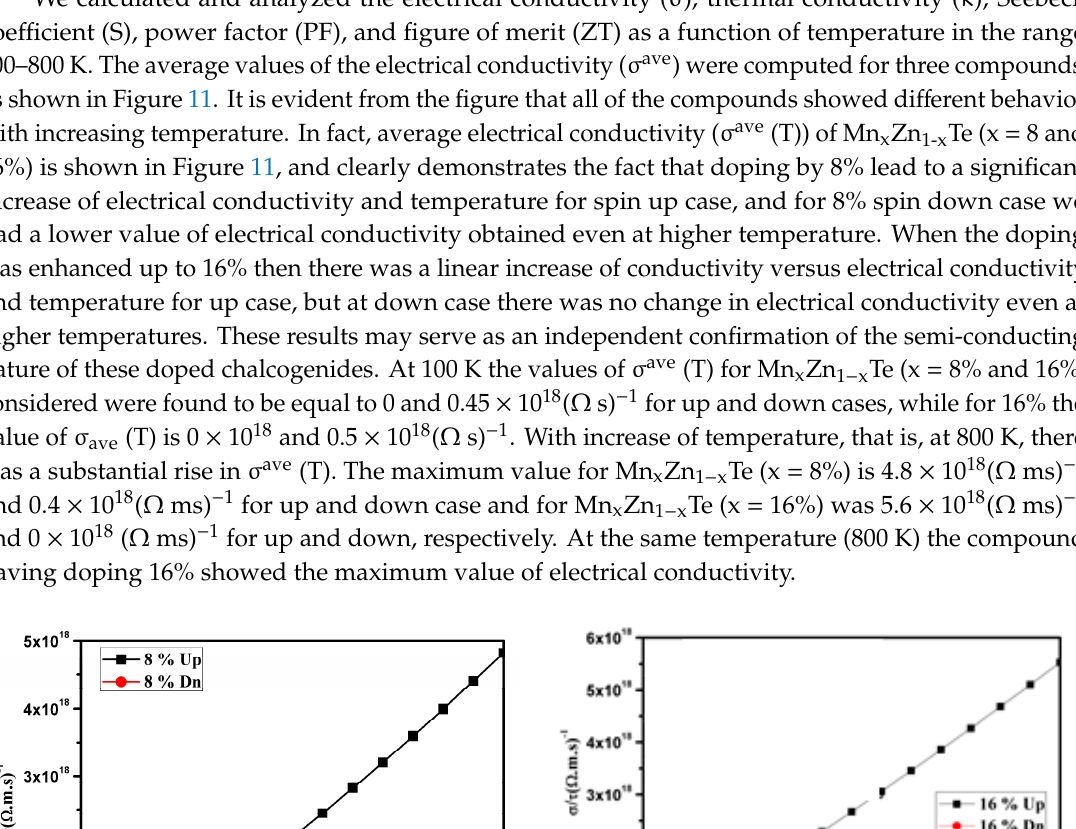
Figure 10. Calculated energy ‐ loss spectrum (long solid curve ‐ black color for up) and (long solid curve ‐ red color for down) spectra for Mn x Zn 1 − x Te (x = 8% and 16%).